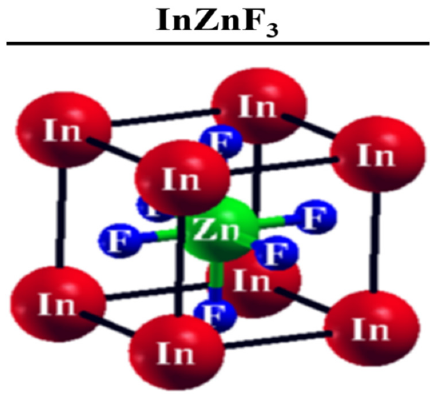
Figure 1. Prototype crystal structure of ternary InZnF 3 .